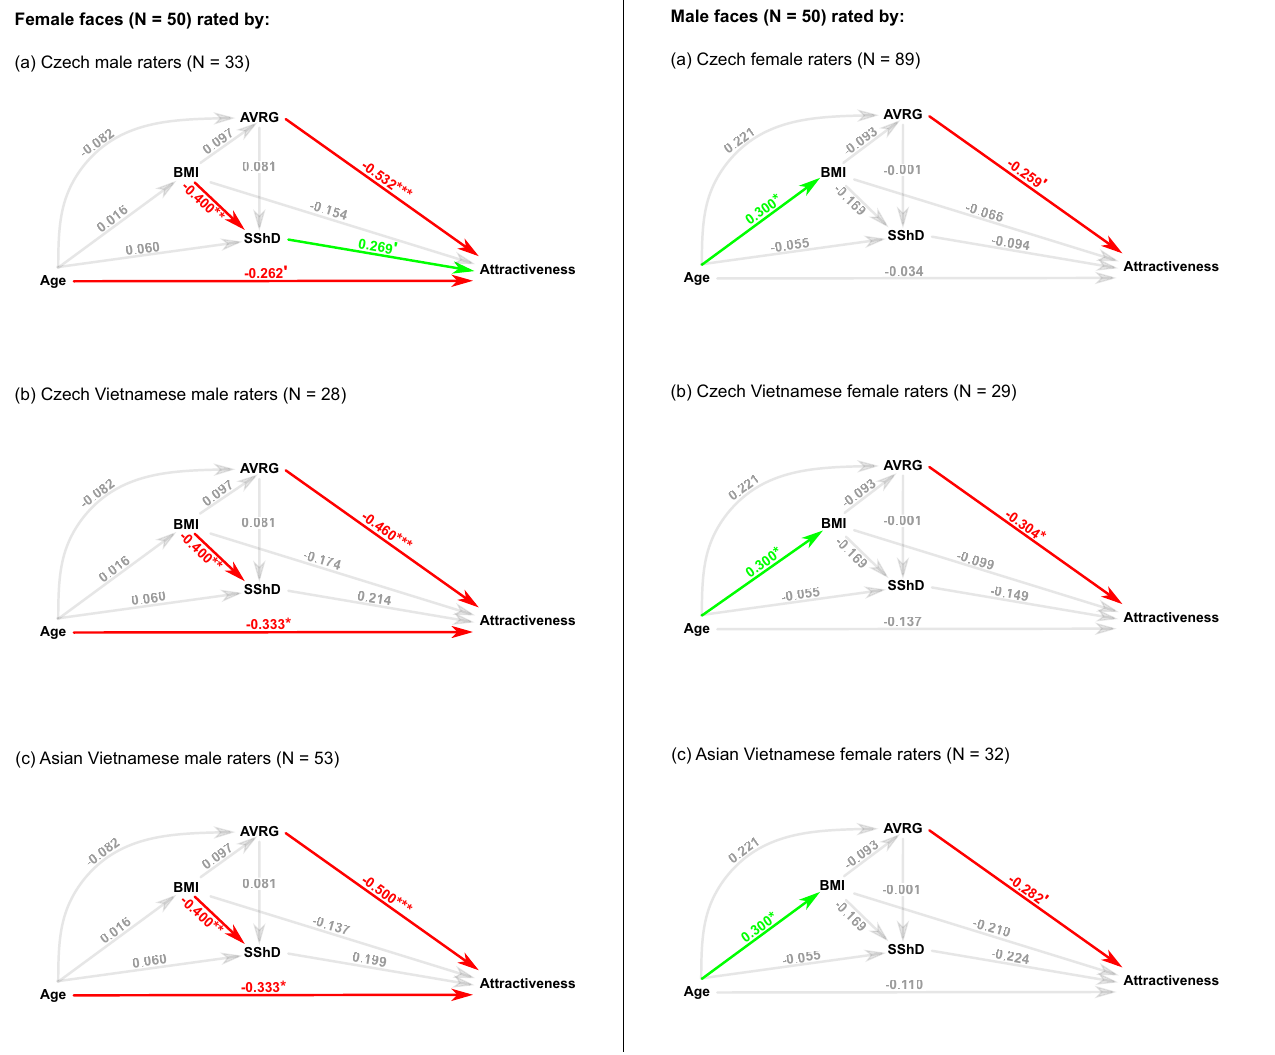
Figure 1. Visualization of path analyses of correlations between reported age, body mass index (BMI), sexual shape dimorphism (SShD), measured averageness (AVRG), and attractiveness. Arrows denote causal directions. The number next to a significant path describes the estimate of regression coefficient of the model with standardized variables. Green color of an arrow denotes a positive coefficient, red color a negative one. Asterisks represent the level of significance (p < 0.05*, p < 0.01**, p < 0.001***) of partial regression coefficient being non- zero. Gray arrows denote absence of a significant relationship. Apostrophe (‘) denotes a nonsignificant trend (p < 0.1, p > 0.05). The higher the SShD value, the more female sex-typical is the facial shape. Lower (negative) values correspond to more masculine facial configurations. A positive association between perceived facial attractiveness and SShD in male faces therefore means that less sex-typical male faces are perceived as more attractive. In female faces, a positive association between SShD and perceived attractiveness indicates that women with more sex-typical (feminine) faces are perceived as more attractive. In both sexes, the negative association between averageness and attractiveness means that more average faces were perceived as more